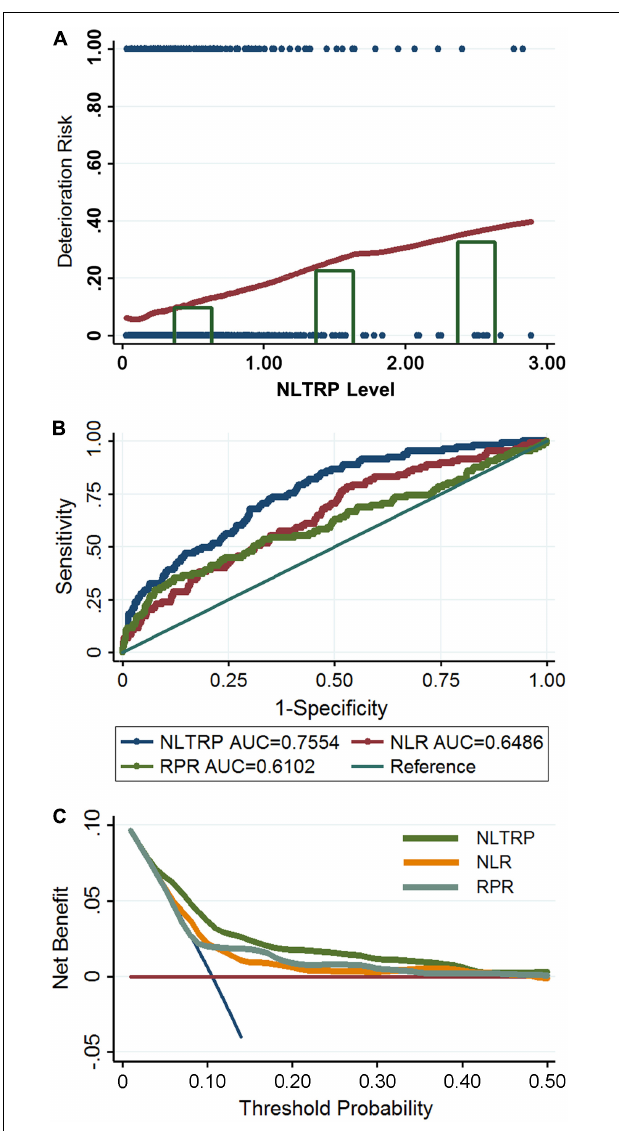
FIGURE 2 | Association between NLTRP and the deterioration risk of patients with mTBI. (A) The Lowess Smoothing revealed an approximately linear relationship between NLTRP and the deterioration risk. The NLTRP values were divided into tertiles, and the third ( > 2) and the second tertiles (1–2) were associated with high deterioration risk, compared to the first (0–1) tertile. The blue dot represents each patient enrolled in the cohort. Individuals with a deterioration outcome were presented with the risk of 1, and those with a non-deterioration outcome were presented with a risk of 0. (B) The ROC curve for NLTRP, NLR, and RPR. (C) The DCA for NLTRP, NLR, and RPR. AUC, area under curve; DCA, decision curve analysis; ROC, receiver-operating characteristic; mTBI, mild traumatic brain injury; NLR, neutrophil-to-lymphocyte ratio; RPR, red cell distribution width-to-platelet ratio; NLTRP, neutrophil-to-lymphocyte ratio times red cell distribution width-to-platelet ratio.